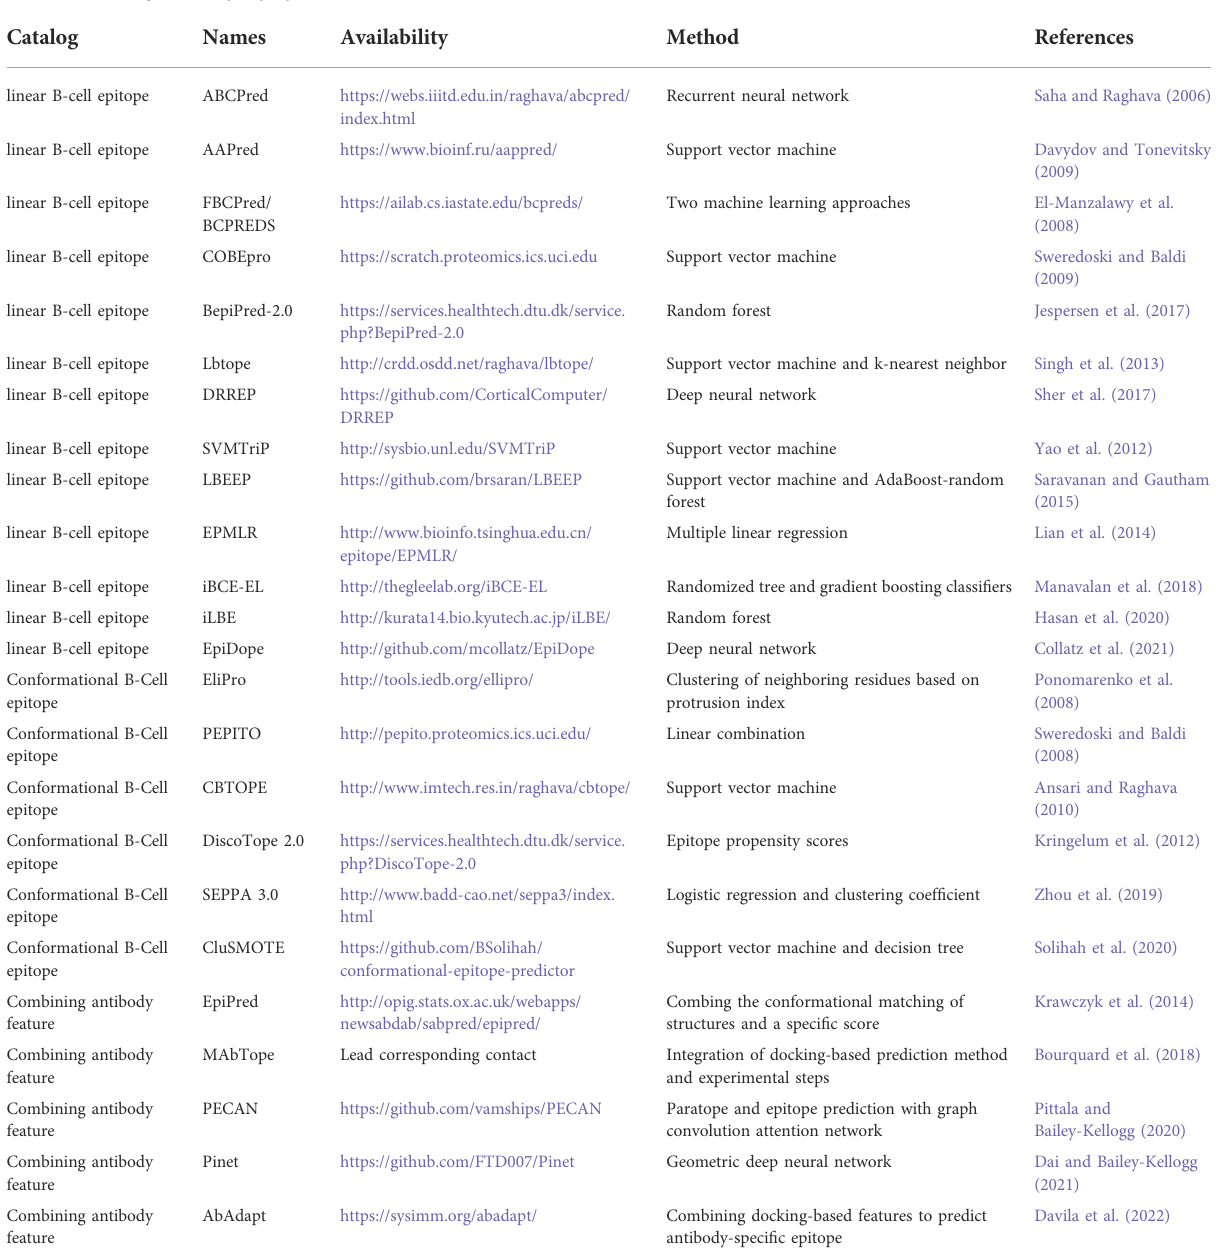
TABLE 1 Summary of the epitope prediction